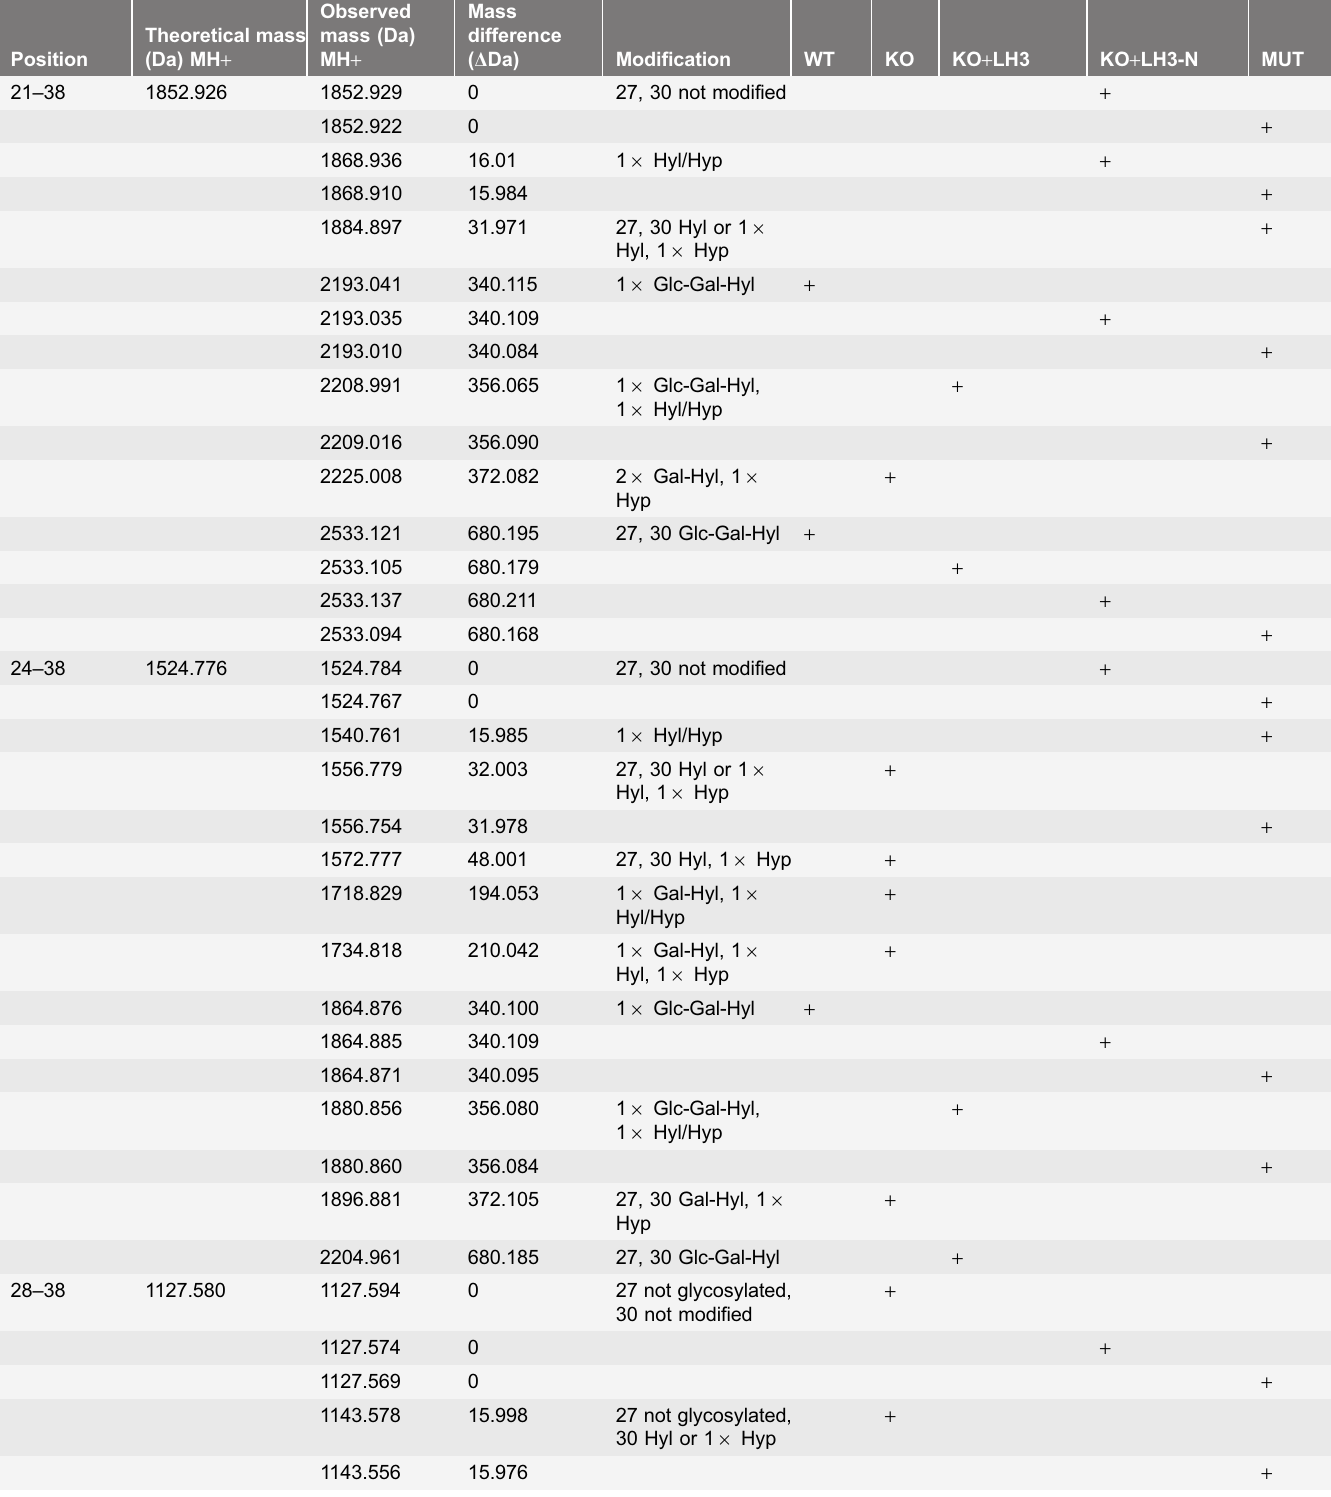
Table 1. Mass spectrometry identification of peptides and modifications from tryptic digests of recombinant rat